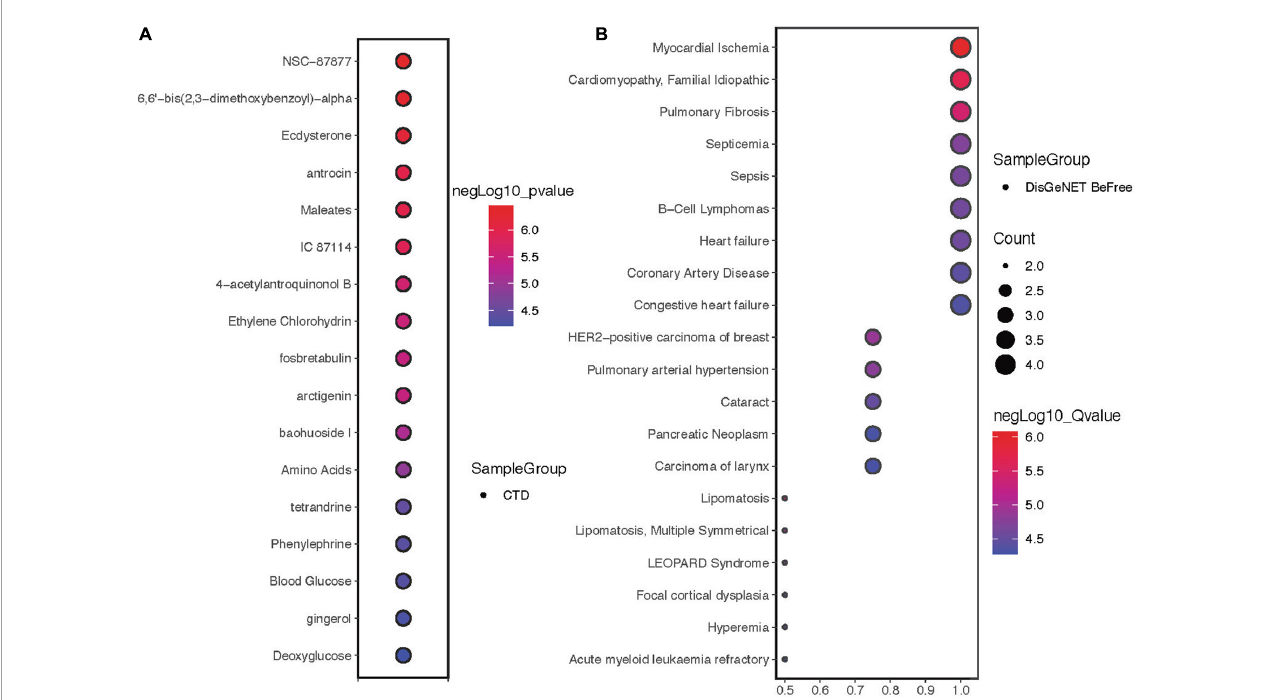
FIGURE5 Drug sensitivity and disease correlation analysis of hub proteins. (A) Drug sensitivity correlation analysis of hub proteins. (B) Disease correlation analysis of hub